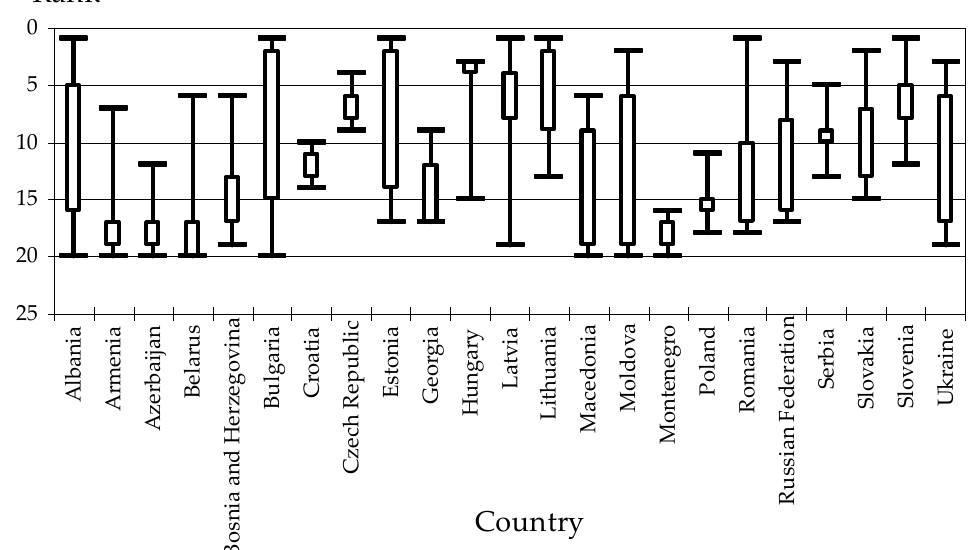
Figure 2. Showing the visibility of articles published on “dentistry” in Eastern European countries during 2010–2018, measured based on the adjusted number of citations per document. The figure displays the ranks of countries computed for each year separately. Results indicate a huge variability and inconsistent patterns for most of the countries analyzed.